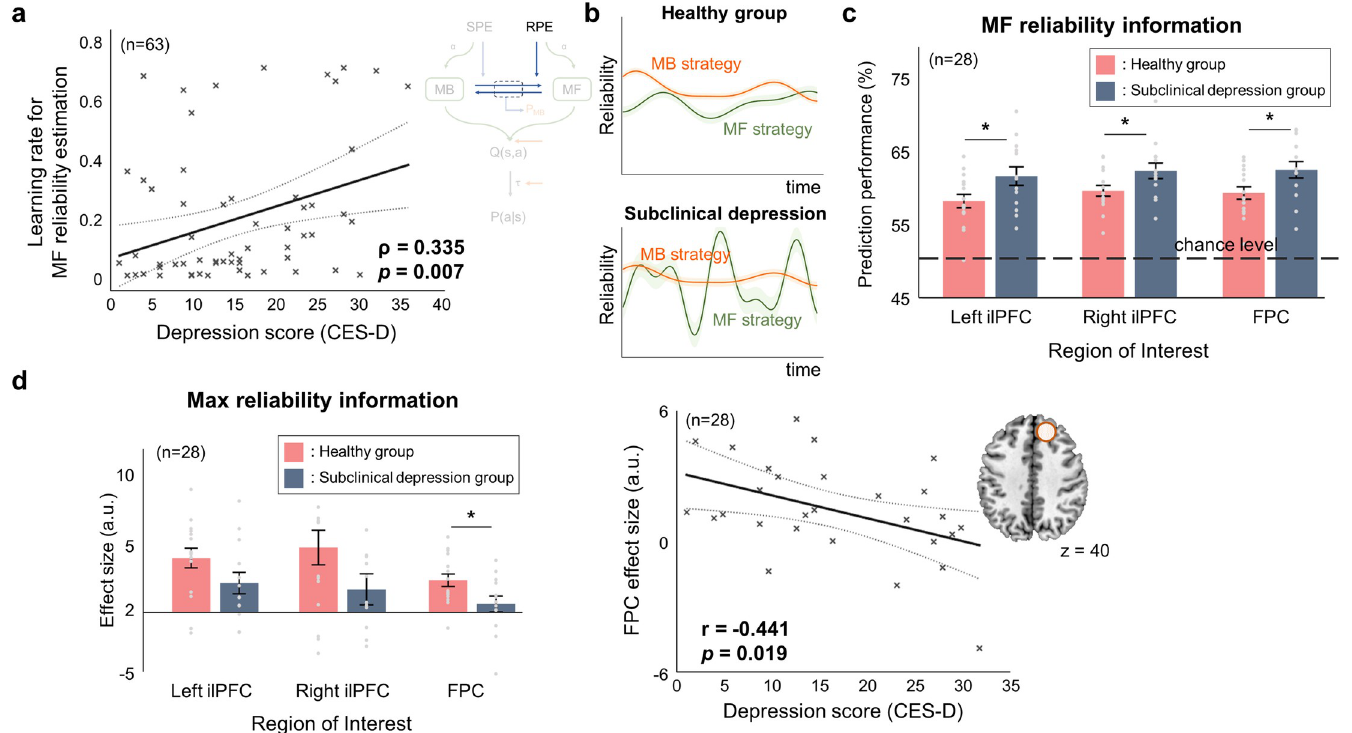
Fig 7. Depression impacts on prefrontal arbitration control. (a) Relationship between the depression score and the learning rate parameter for reliability estimation of the model-free system (n = 63; the total number of subjects, including 35 who participated behavioral experiment only and 28 who were also scanned with the fMRI). Individuals with a higher depression score tend to exhibit a higher learning rate, indicating that their reliability estimation for the model-free system is very sensitive to reward prediction error (RPE). (b) Illustrative examples of reliability changes of people with a low (“healthy group”) and a high depression score (“subclinical depression group”), each of which is associated with a low and a high learning rate for reliability estimation, respectively. The subclinical depression group shows rapid changes in MF reliability due to higher learning rate. (c) Quantification of the amount of reliability information of the model-free system for the healthy (n = 15) and depressive (n = 13) group (MVPA analysis). The MVPA analysis with these three seed regions reveals that the amount of information about the model-free reliability was significantly higher in the subclinical depression group in all three regions (one-way ANOVA). Asterisk ( � ) indicates significant difference at the 0.05 level. (d) (Left) The parameter estimates of the Max reliability for the bilateral inferior lateral prefrontal cortex (ilPFC) ([–52,26,16], z-score = 4.48; [42,20,–8], z-score = 3.61) and FPC ([8,44,40], z-score = 3.83). Their effect sizes tend to be smaller in the subclinical depression group. (Right) Relationship between the depression score and the estimated effect size of Max reliability for frontopolar cortex (FPC), the brain area implicated in arbitration control. The estimated effect size of the Max reliability signal for FPC is negatively correlated with the depression